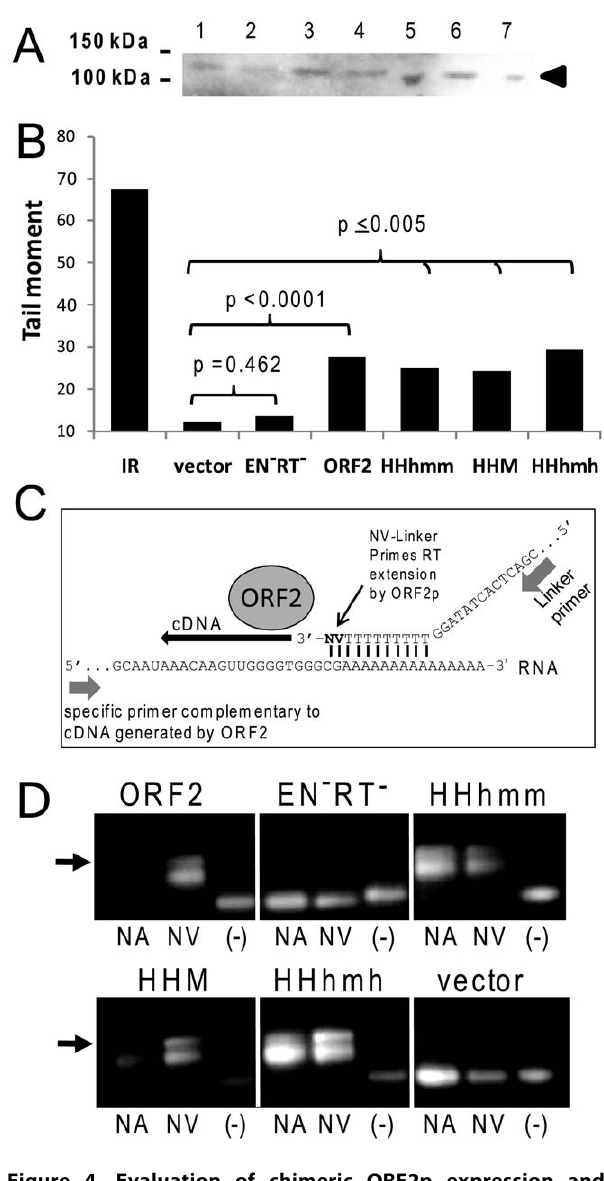
Figure 4. Evaluation of chimeric ORF2p expression and functionality. A. Detection of ORF2 protein. Western blot analysis of extracts from transiently transfected HeLa cells with constructs expressing the following human-mouse ORF2 chimeric proteins: 1- MMmhh, 2- HHhmm, 3- HHM, 4- MMH, 5- HHhmh, 6- HHmhh, and 7- optimized human ORF2 (HHH). An arrow indicates the expected position of the 149 kDa ORF2 protein. B. Evaluation of endonucle- ase activity. Alkaline comet assay for the detection of DNA breaks of transiently transfected cells plasmids expressing the optimized human ORF2 (HHH), an endonuclease and reverse transcriptase